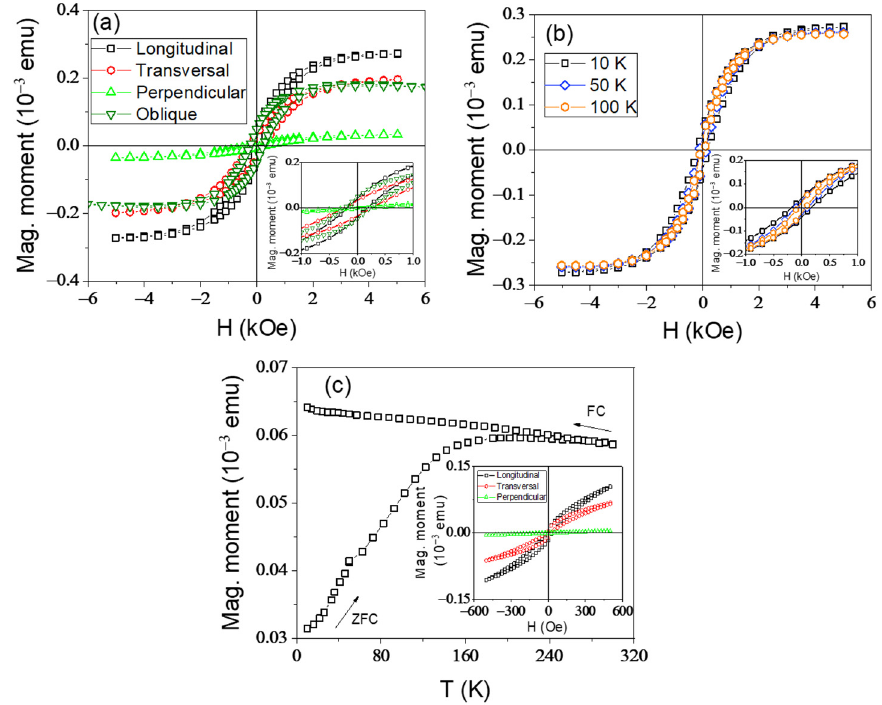
Figure 4. Hysteresis loops of FeCo sample collected at 10 K in longitudinal, transversal, oblique, and perpendicular geometry ( a ); hysteresis loops as a function of temperature in longitudinal geometry ( b ). Insets present an enlarged image of the hysteresis loops around the origin. ZFC-FC curves collected with 200 Oe applied field in longitudinal geometry. Inset shows the hysteresis loops collected at 300 K in different geometries ( c ).